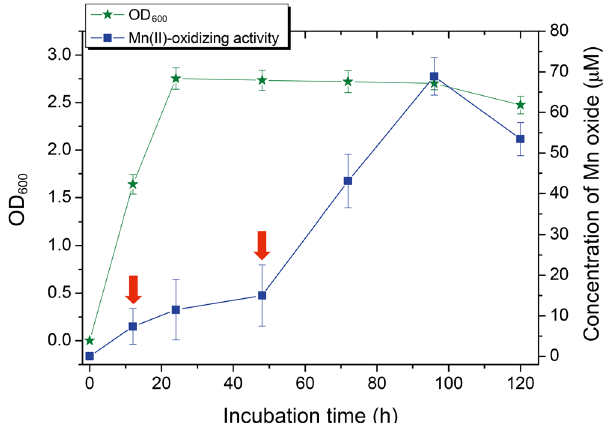
Figure 1. Growth curve and Mn oxidation activity of E . coli MB266. The green curve represents the growth curve of E . coli MB266. After inoculation in 250-mL flasks with a 1% inoculum size, the OD 600nm value of the culture was determined over a period of 5 d during which the cells were grown in liquid Lept medium. The blue curve shows the changes in the Mn oxidation activity of E . coli MB266. The time points used for the proteomic analyses are indicated by